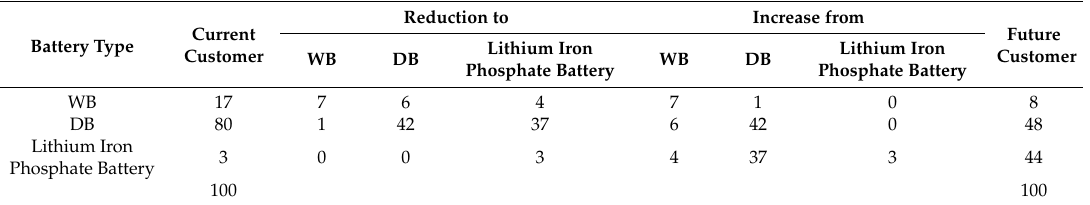
Table 1. Prime Algebra Matrix.